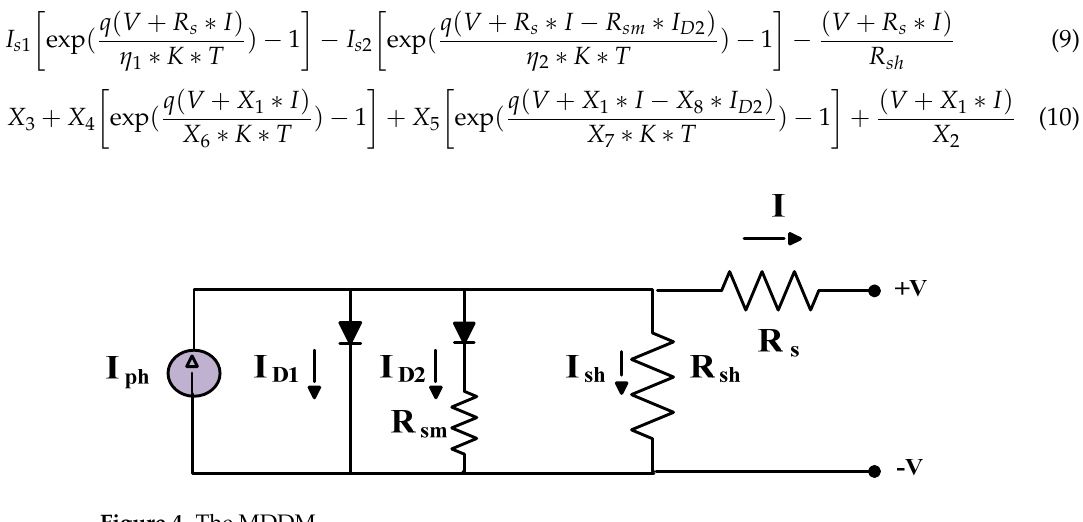
Figure 4. The MDDM.